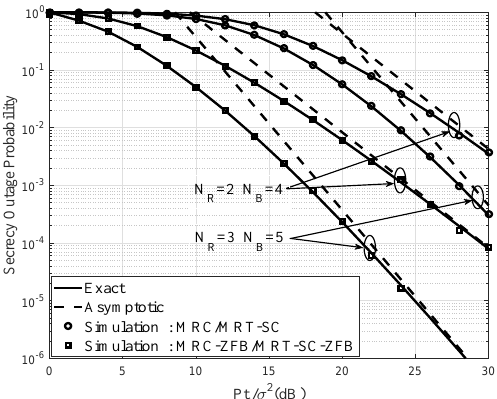
Figure 4. Exact and asymptotic secrecy outage probability for the MRC/MRT-SC and MRC-ZFB/MRT-SC-ZFB schemes under Scenario I when γ E = 10 dB, γ J = 10 dB and different values N R and N B .